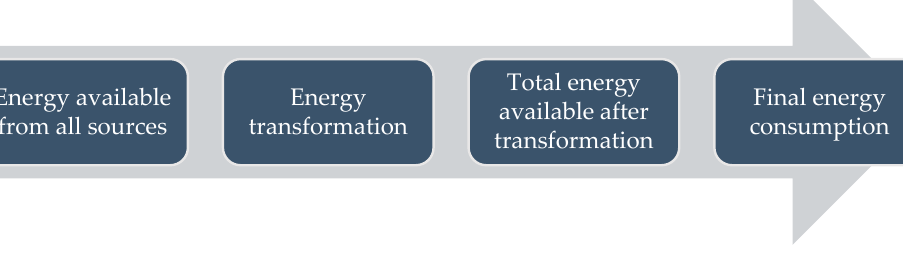
Figure 4. Different energy phases of the energy balance.